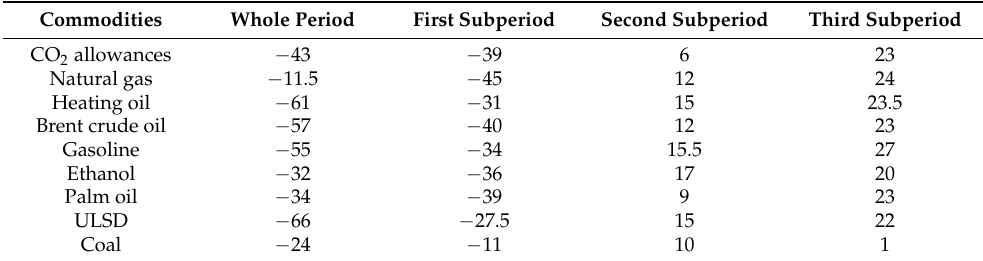
Table 2. Median differences (in days) between the indices of the COVID-19 daily cases and prices of